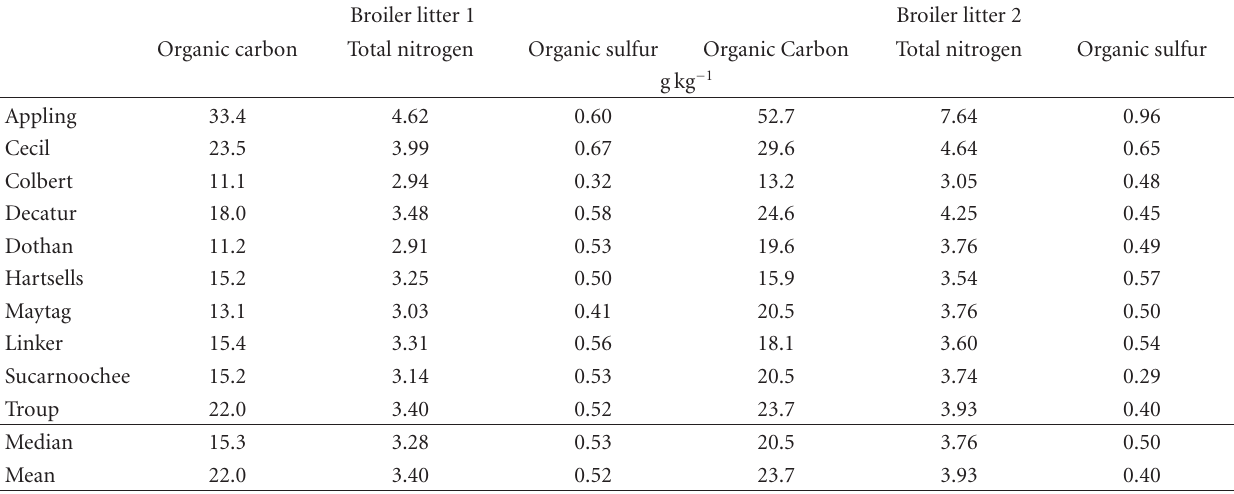
Table 3: Organic carbon, sulfur, and total nitrogen contents of soil-amended with broiler litter sample 1 or 2 before aerobic incubation studies †